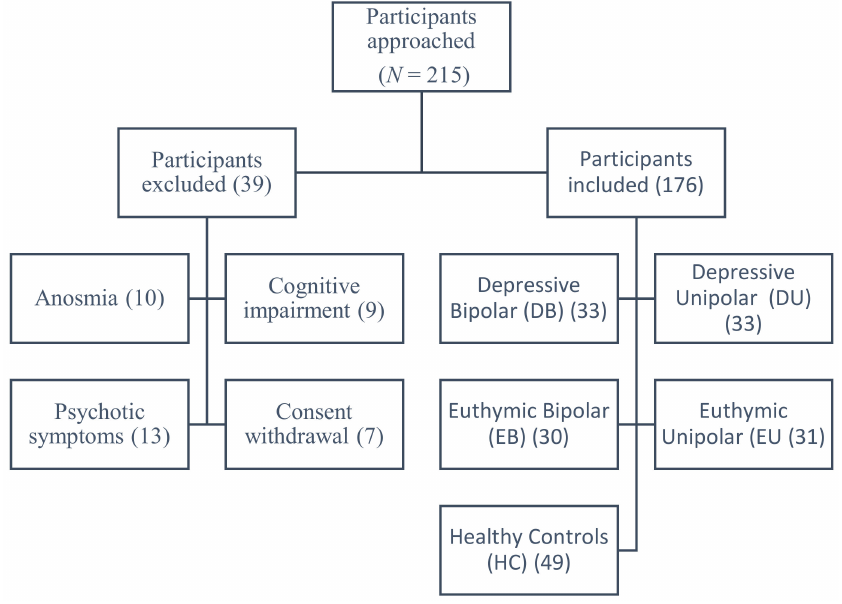
Figure 1. Flow diagram of participants’